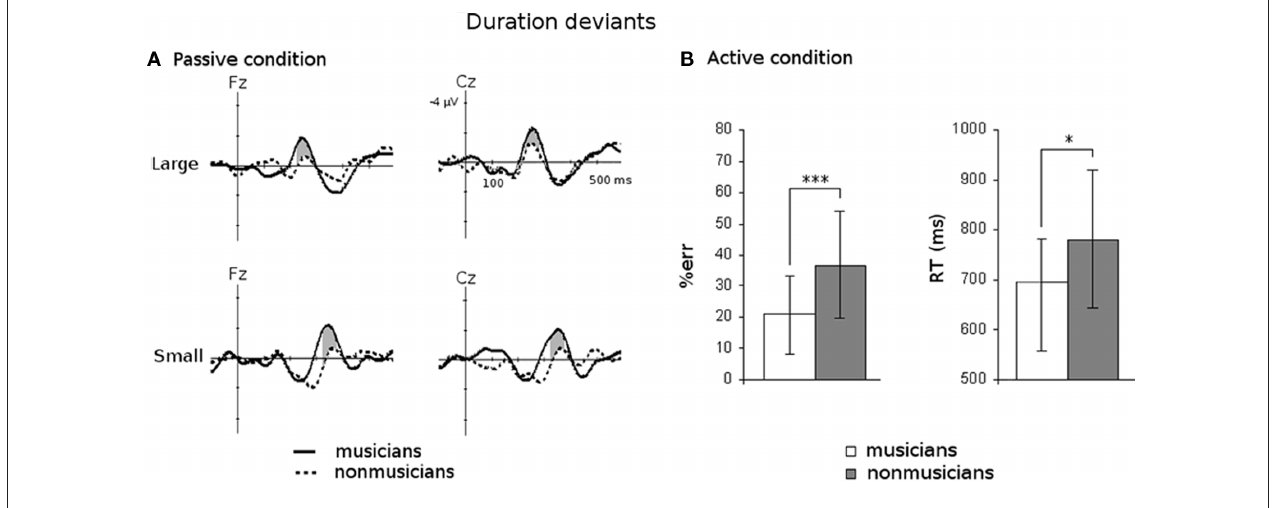
(RTs) to duration deviants (collapsed across large and small deviants) in the active discrimination task. Percentage of errors was lower and RTs were shorter for musician than for non-musician children. Thus, the active processing of the duration of speech sound is also enhanced in musician compared to non-musician children. Adapted from Chobert et al., accepted.